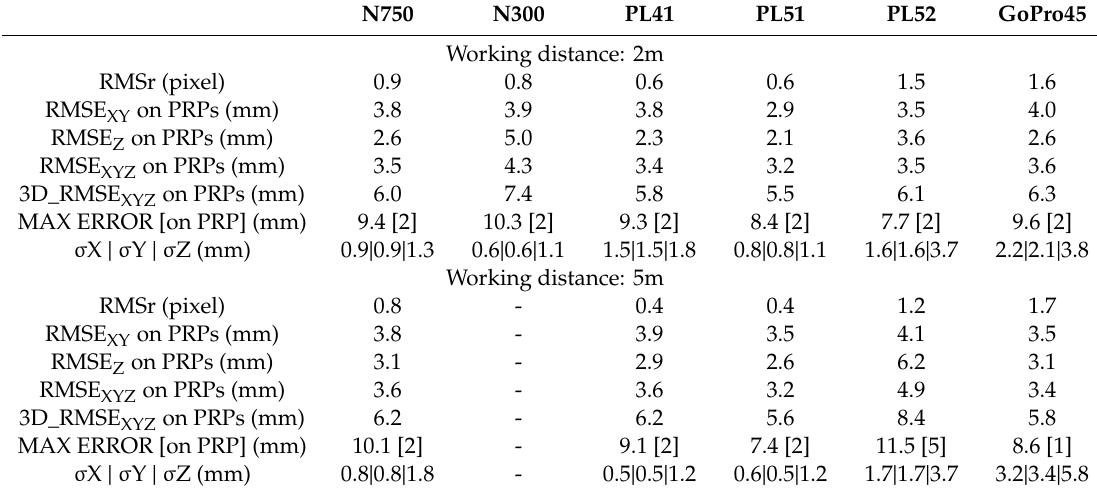
Table 5. Independent check: comparison between the photogrammetric solutions and primary control network.